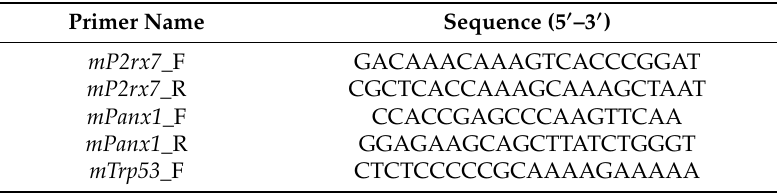
Table 1. Primer list and